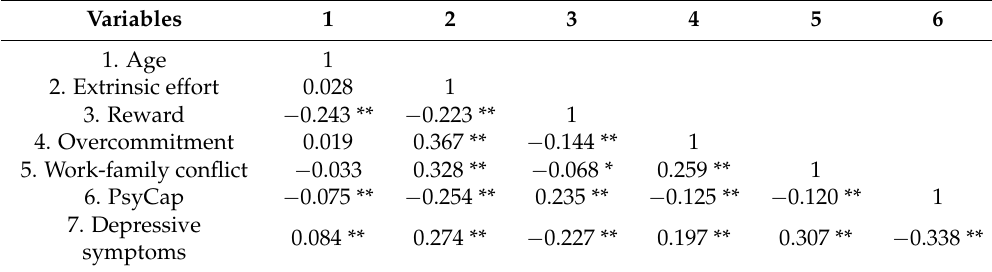
Correlations among extrinsic effort, reward, overcommitment, work-family conflict, psychological capital (PsyCap) and depressive symptoms ( n =